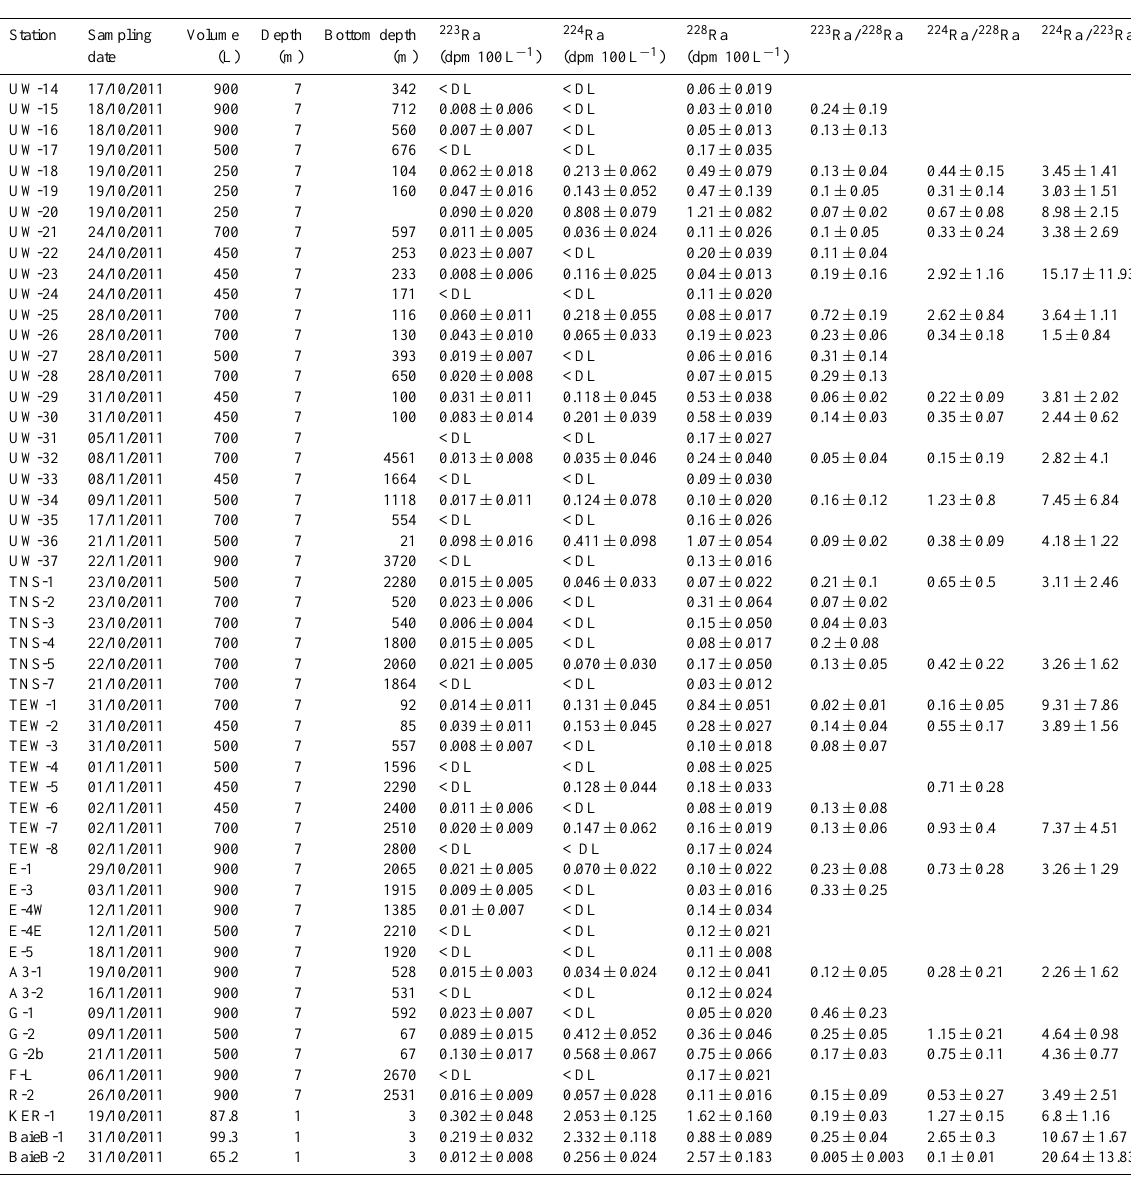
Table 1. Dissolved 223 Ra, 224 Ra and 228 Ra activities determined in surface samples collected off the Kerguelen Islands. The 223 Ra and 224 Ra activities are excess radium activities (see Methods for details). Activities are expressed in disintegration per minute per 100L (dpm100L − 1 ). <DL denotes below the detection